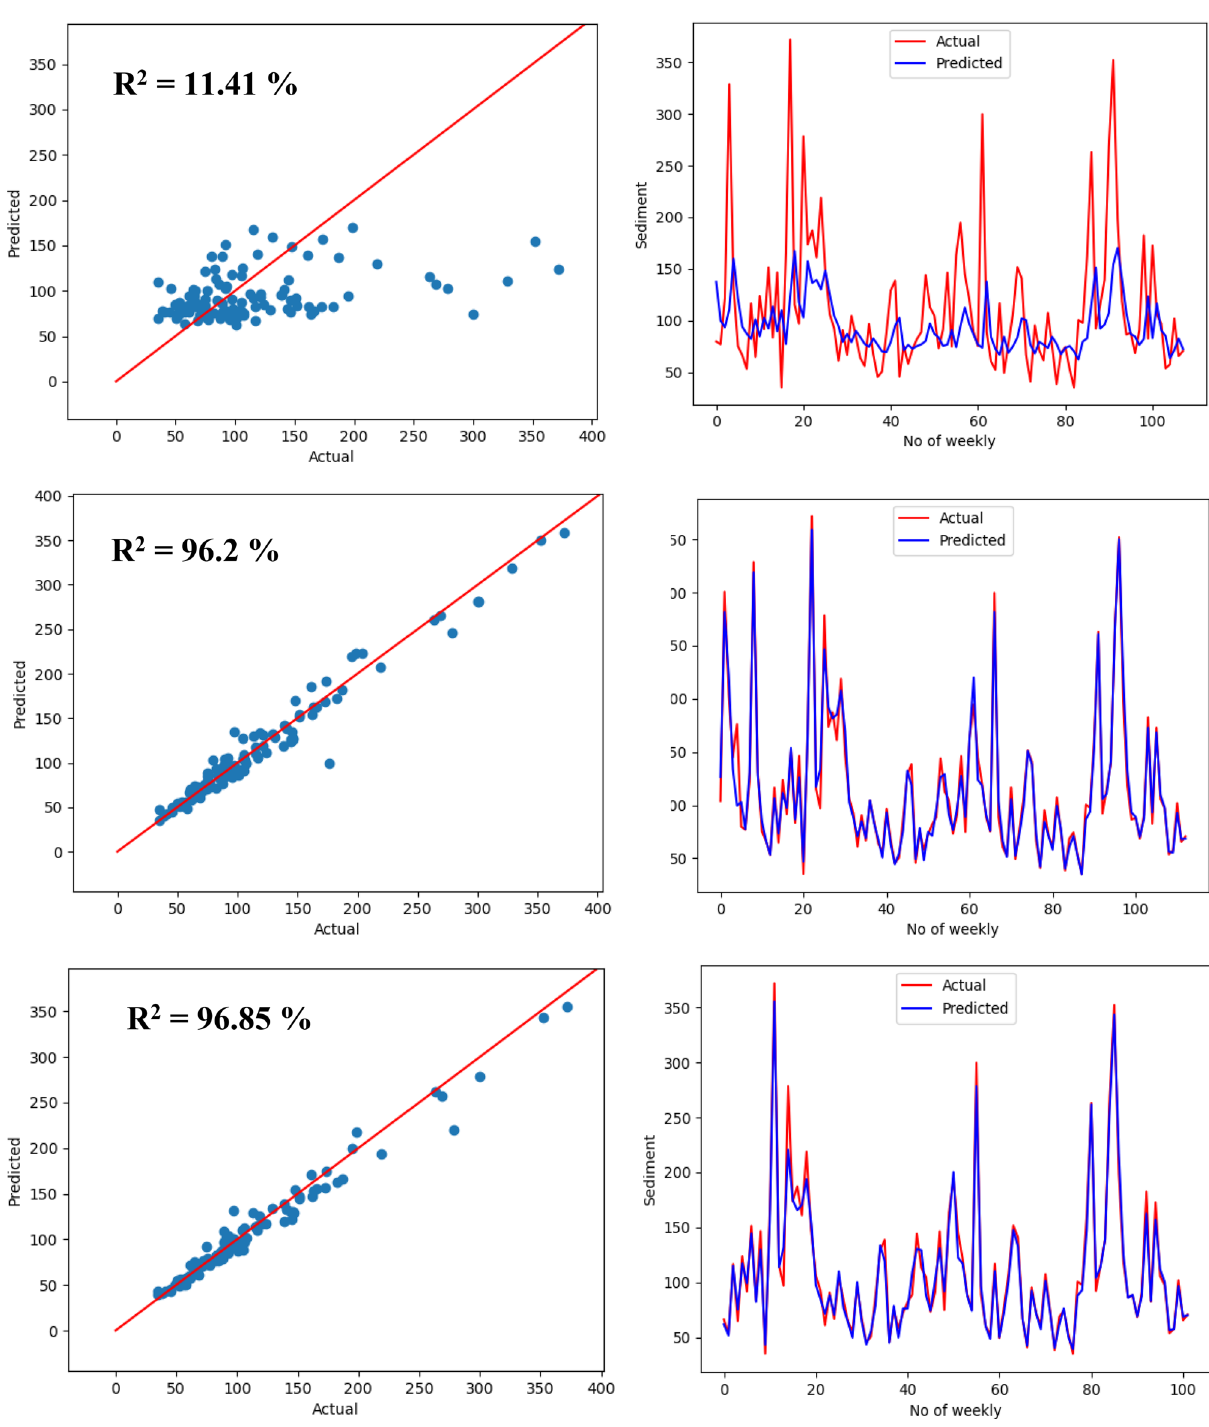
Figure 17. Scatter plot and signal plot of actual sediment versus forecasted sediment for LSTM for the weekly scenario for different inputs: sediment only (first row), discharge only (second row), sediment and discharge (third